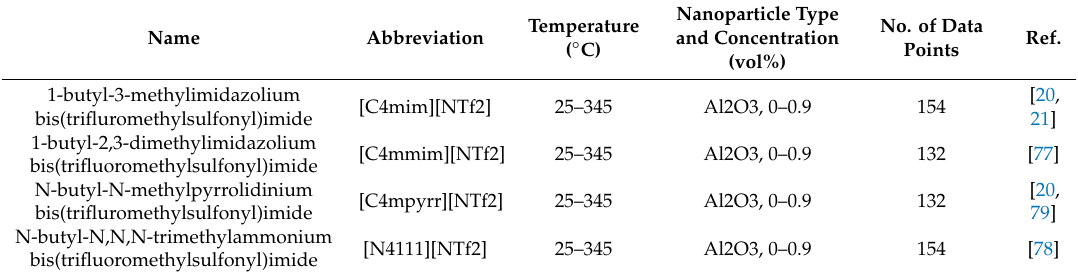
Table 1. The list of ionic liquids (ILs) studied in the literature for the prediction of C p